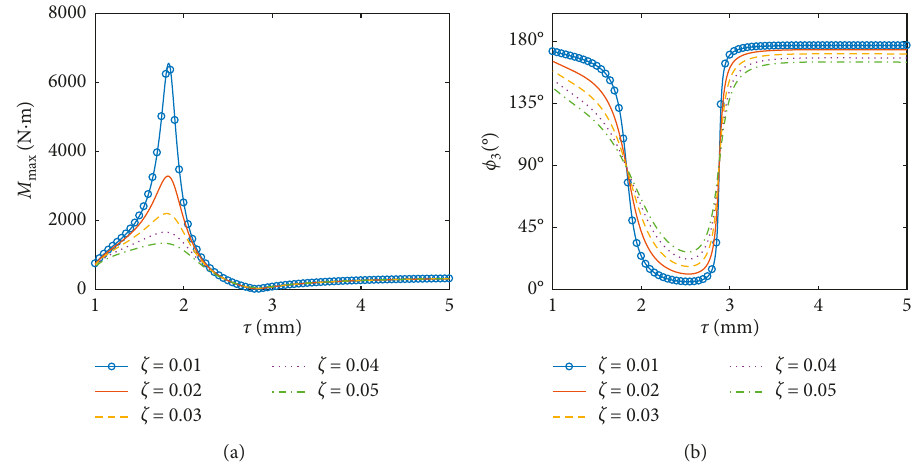
Figure 18: The amplitudes and the phases of resultant moment versus the thickness of the flexible baffle for R (a) the amplitude of the resultant moment, (b) the phase of the resultant